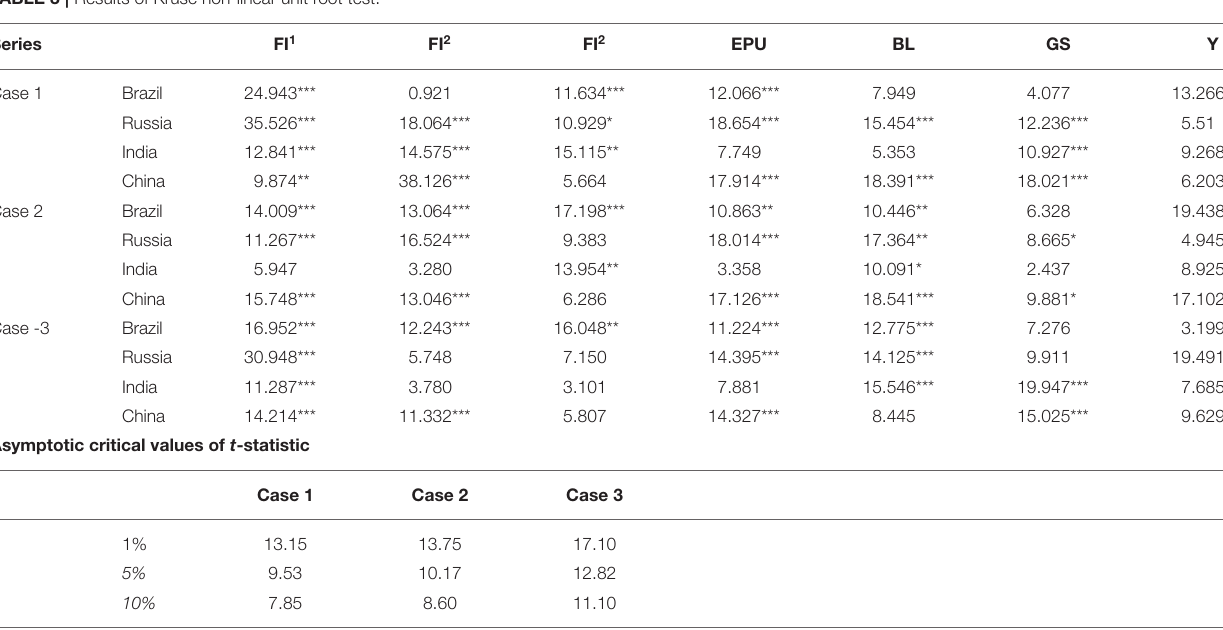
TABLE 3 | Results of Kruse non-linear unit root